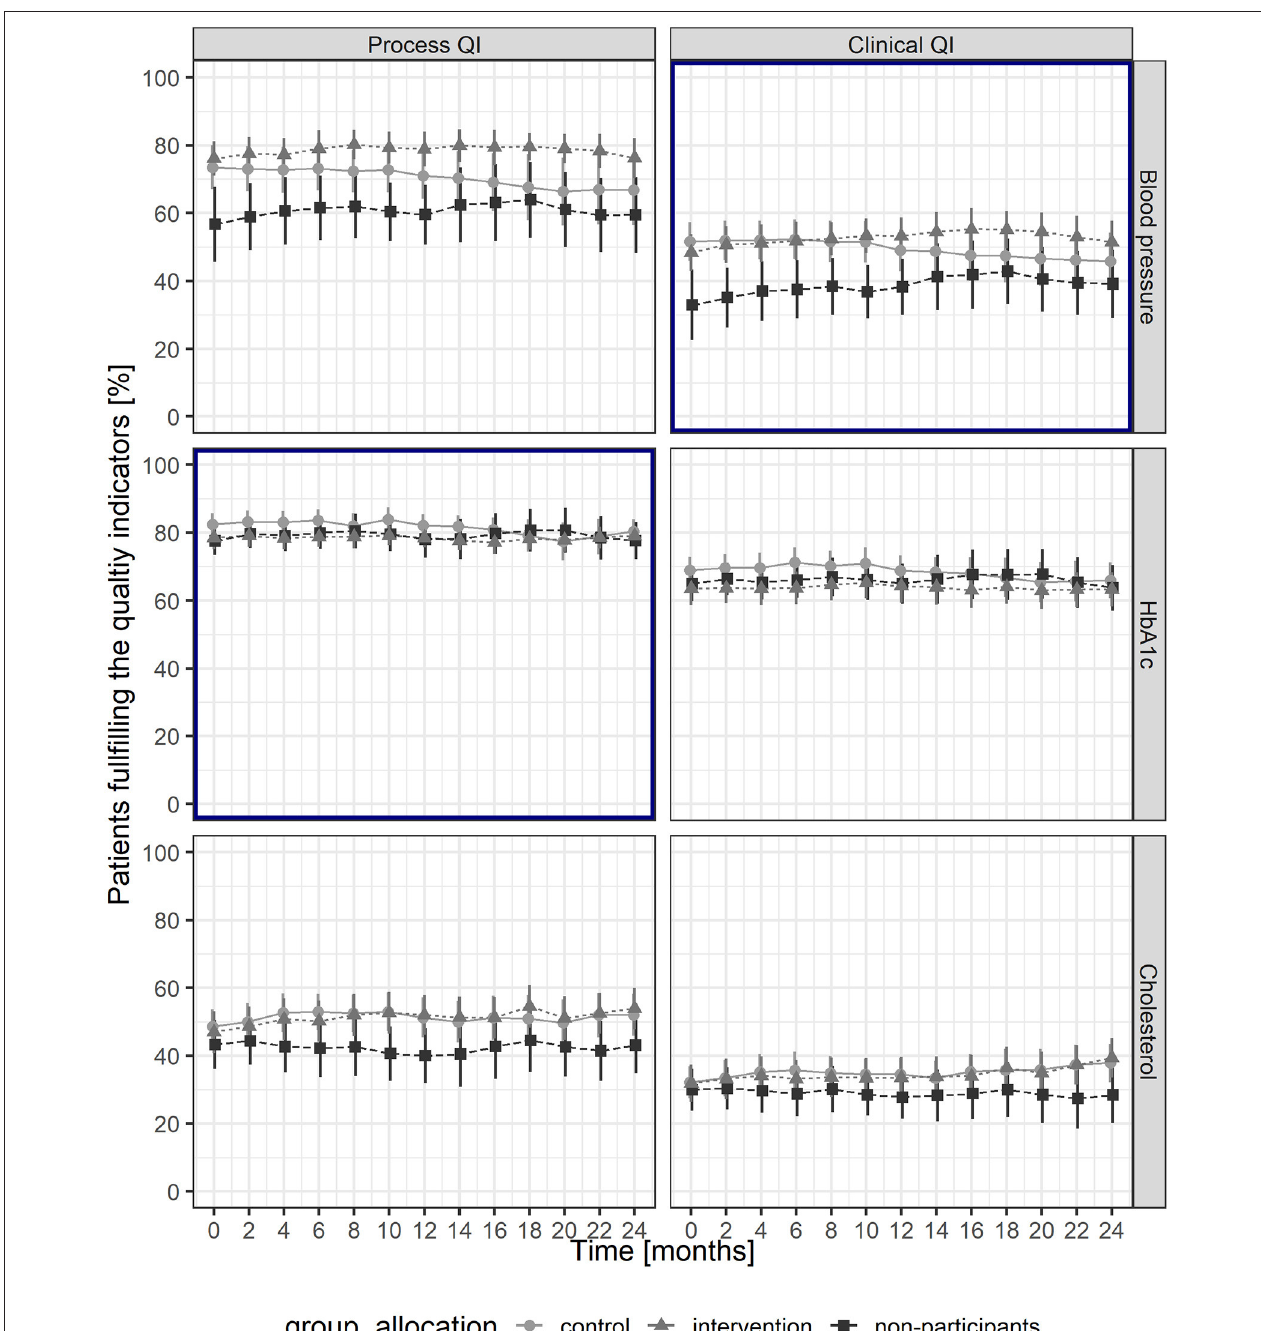
FIGURE 2 | Proportions of patients fulfilling the quality indicators throughout the study period, with mean and Wald-95% CI for each group. Bold frames indicate primary outcomes. QI, quality indicator.